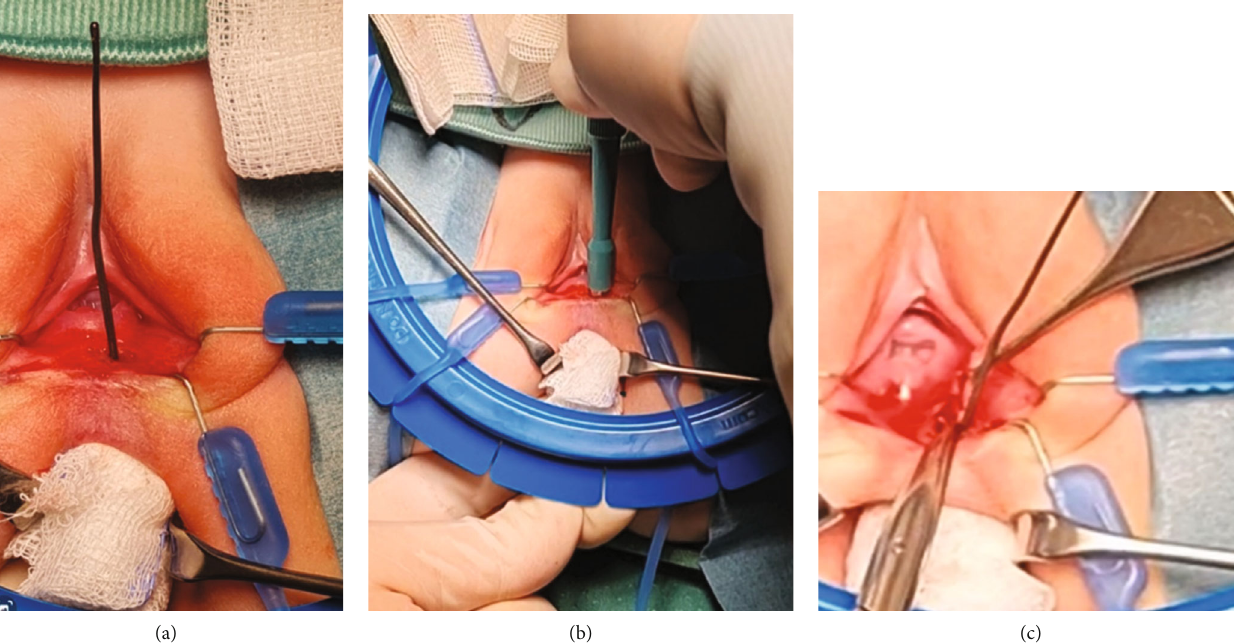
Figure 2: Excision of the fi stula tract with a 4-mm biopsy